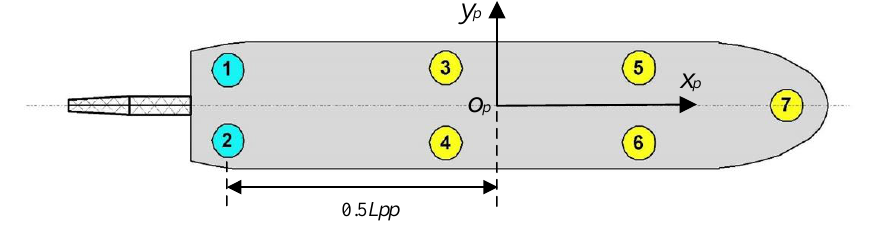
Figure 5. The wind coefficients for HYSY201.